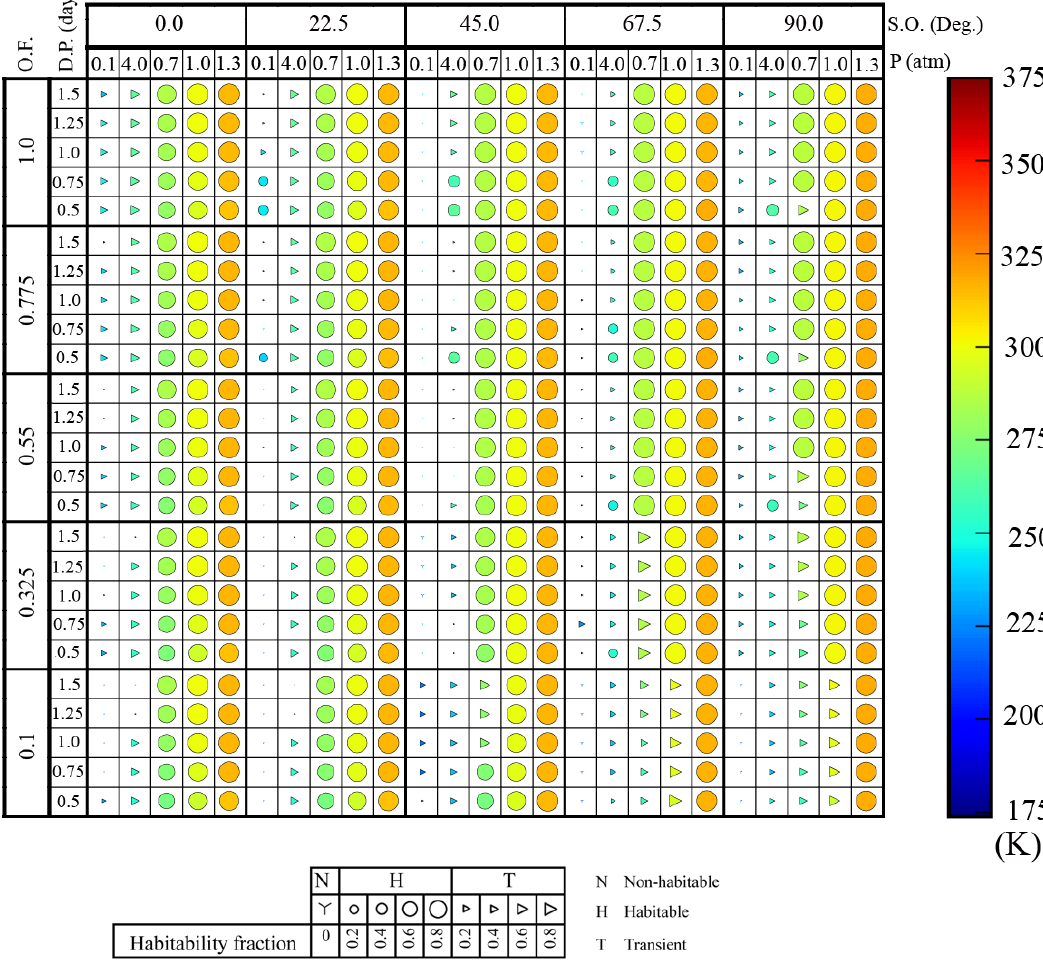
Figure 6. Kepler-22b parameters map - All parameters are in an increasing order from left to right and bottom to up. Pressures are (0.1, 0.4, 0.7, 1, 1.3) atm, Diurnal Periods are (0.5, 0.75, 1.0, 1.25, 1.5) days, Spin Obliquities are (0.0, 22.5, 45.0, 67.5, 90.0) degrees, and Ocean Fractions are (0.1, 0.325, 0.55, 0.775, 1.0). They are displayed in the map,